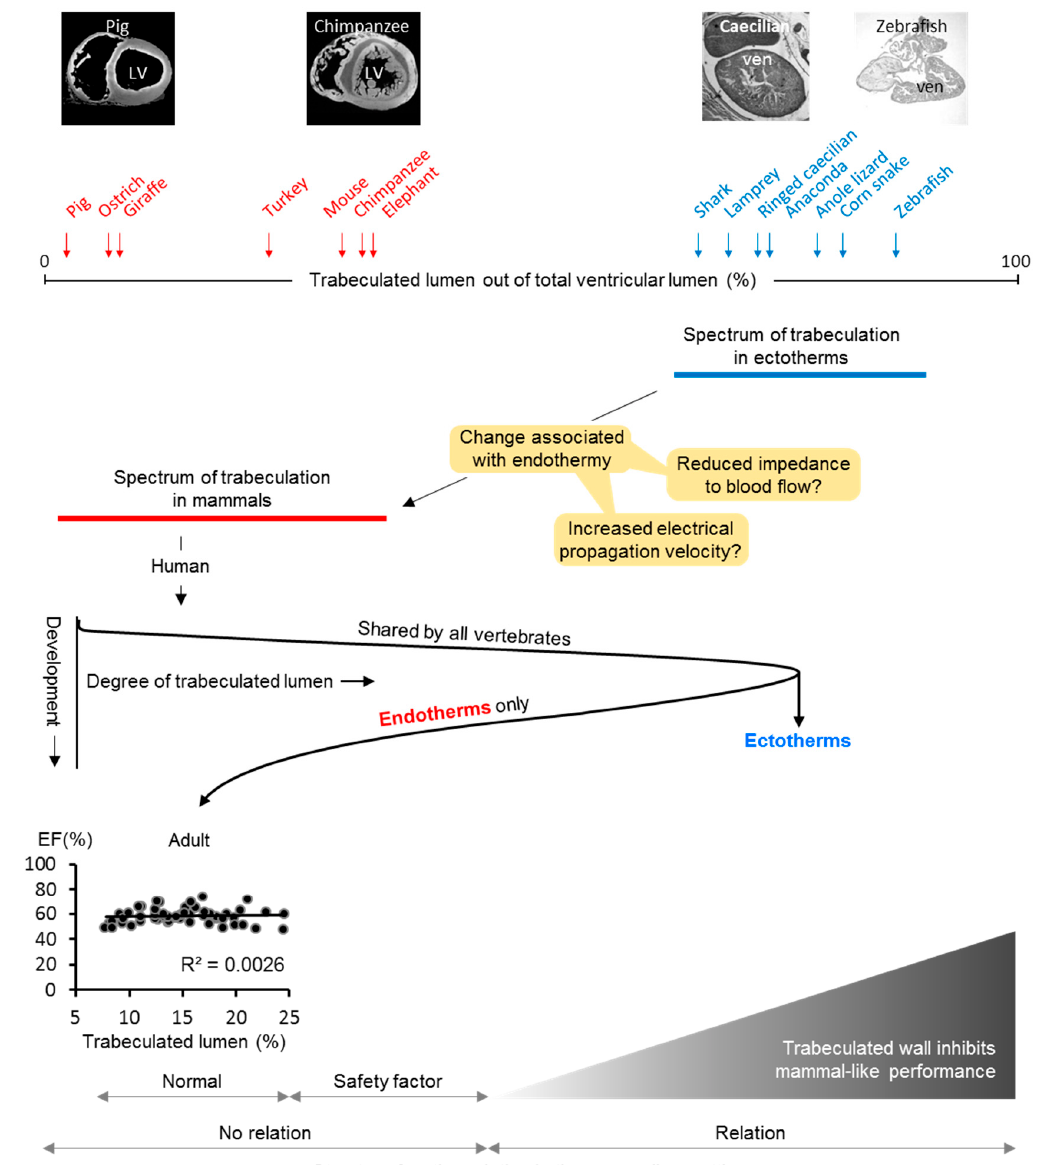
Figure 4. Evolutionary transition from trabeculated to compact chamber walls. In the evolution from ectothermy to endothermy, the cardiac chambers became much less trabeculated and the chamber walls became compact. This change (orange boxes) may have been impacted on the heart by reducing impedance to flow and accelerated chamber activation times, both of which would facilitate a short cardiac cycle and, thus, the high heart rates that characterizes the endotherms. In development, all vertebrates form highly trabeculated chambers, but, only in endotherms, is this design reversed by a temporary slow-down in proliferation of the trabeculated muscle while proliferation is maintained in the compact wall [42–44]. In the adult (human), there is variation in the extent of trabeculated muscle, but this extent does not associate with functional measures. Nonetheless, extremely excessive trabeculated ventricles, ectotherm-like, appear incompatible with life in endotherms [88]. This suggests that the extent of trabeculated myocardium in endotherms will have a normal range, a safety factor range where excessive extent of trabeculated myocardium is not pathological, and an ectotherm-like range, which will be detrimental to pumping function, possibly because of the impairment of filling and emptying. This is partly based on and adapted from Reference [45].